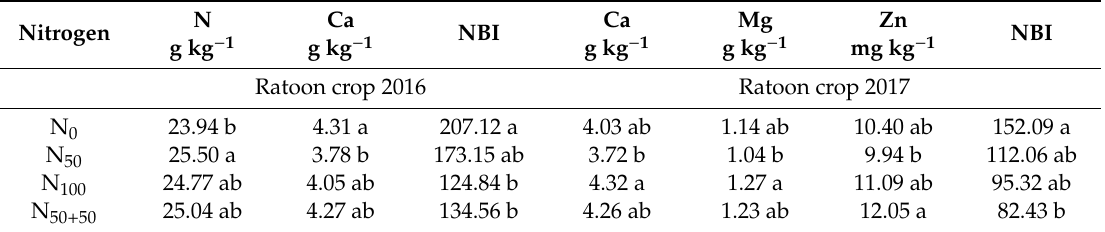
Table 5. Least Square means for nitrogen main e ff ects on sugarcane leaf tissue nutrient concentration and nutrient balance index (NBI) of ratoon crops.